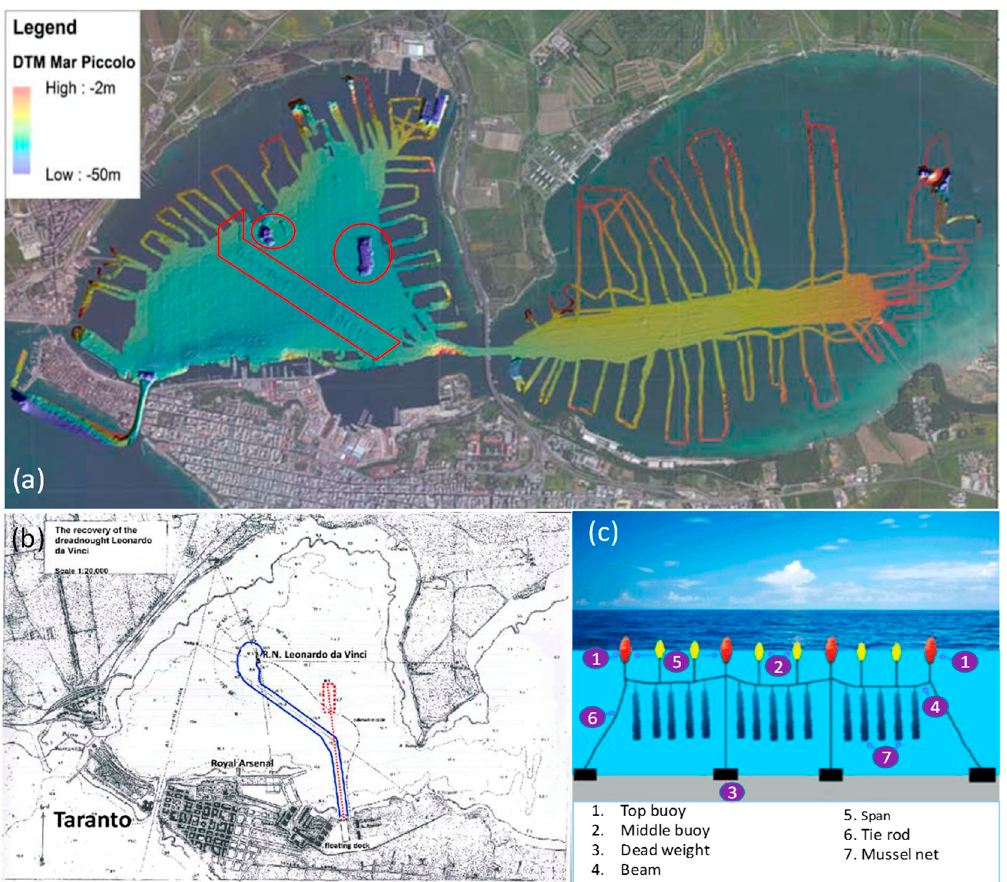
Figure 12. ( a ) DTM of the Mar Piccolo seabed [31], ( b ) Leonardo da Vinci vessel retrieval channel [54], and ( c ) longline mussel farming system. Appl. Sci. 2020 , 10 , x FOR PEER REVIEW